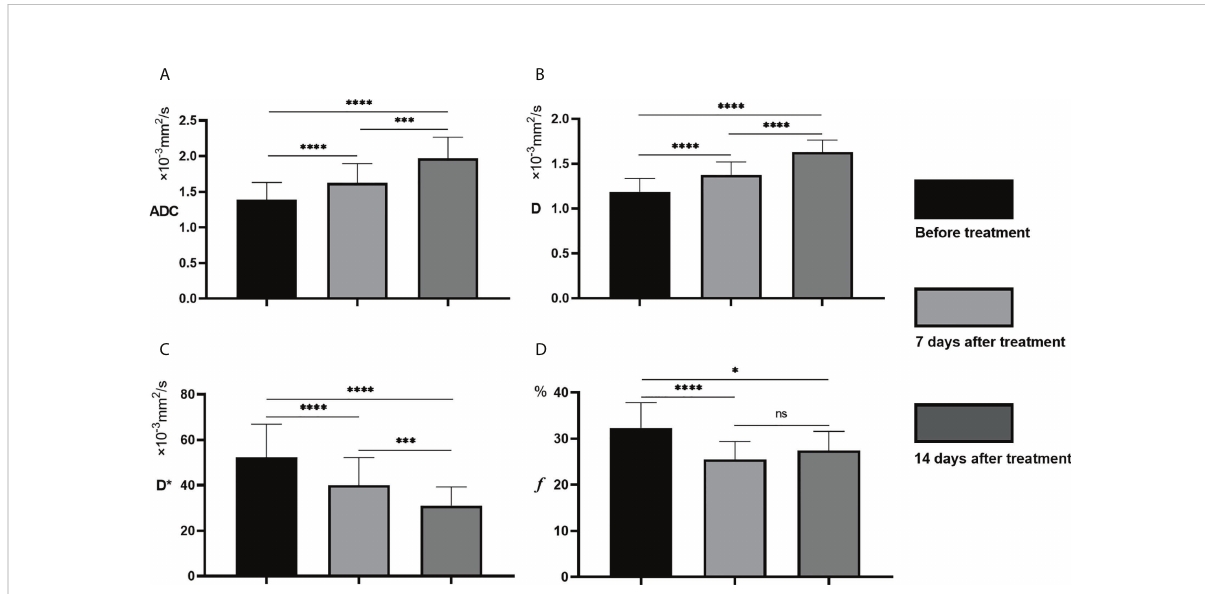
FIGURE 4 Change trend of ADC (A) , D (B) , D* (C) and f (D) before and after treatment. ns represents P >0.05,* P < 0.05, *** P < 0.001, **** P < 0.0001.